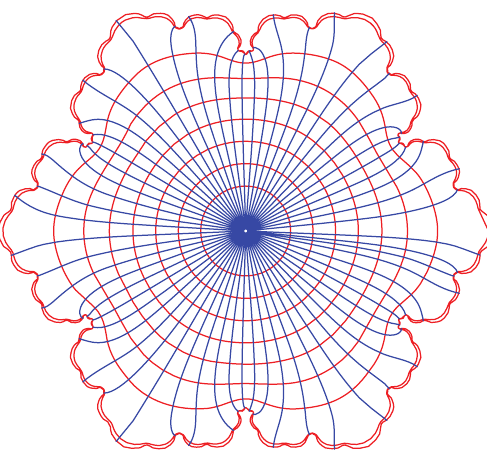
Figure 10: Interior of Koch’s snowflake, Step